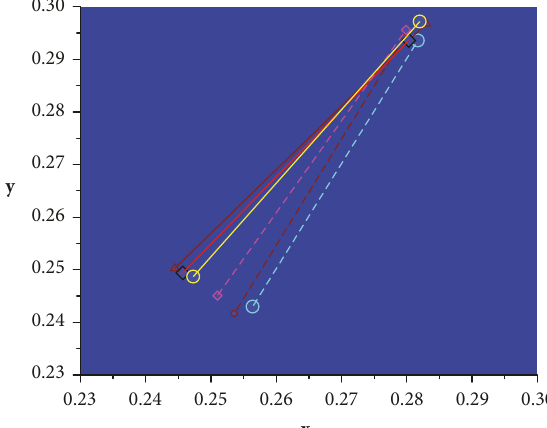
Figure 6: The chromaticity coordinates of measured and simulated results in the dark state and bright state.